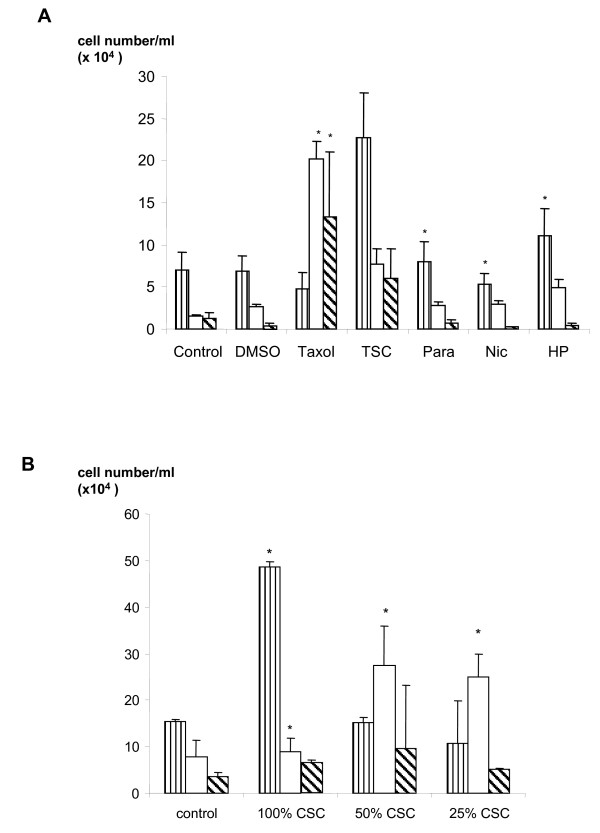
Graph of cell distribution in detached A549 cells after 48 hours of treatment measured by morphological analysis by DAPI staining. Data shown the number of normal, apoptotic or indeterminate cells among the detached cell population as measured by morphological assessment. Cells were seeded at a density of 105 cells per well, prior to treatment in serum free media. (A) Cells were untreated (control) or treated with DMSO (1%), Taxol (1 μM), TSC (80 μg/ml), paraldehyde (Para; 10 μM), nicotine (Nic; 1 mM) and hydrogen peroxide (HP; 10 μM). (B) Cells were untreated (control) or treated with 100%, 50% and 25% CSE. Vertically striped bars show "normal", open bars show "apoptotic" and hatched bars show "indeterminate" cells/ml of the culture and are the mean ± s.e. mean of at least 3 determinations. Asterisks denote statistical significance (p < 0.05) from control cells showing the same morphology.